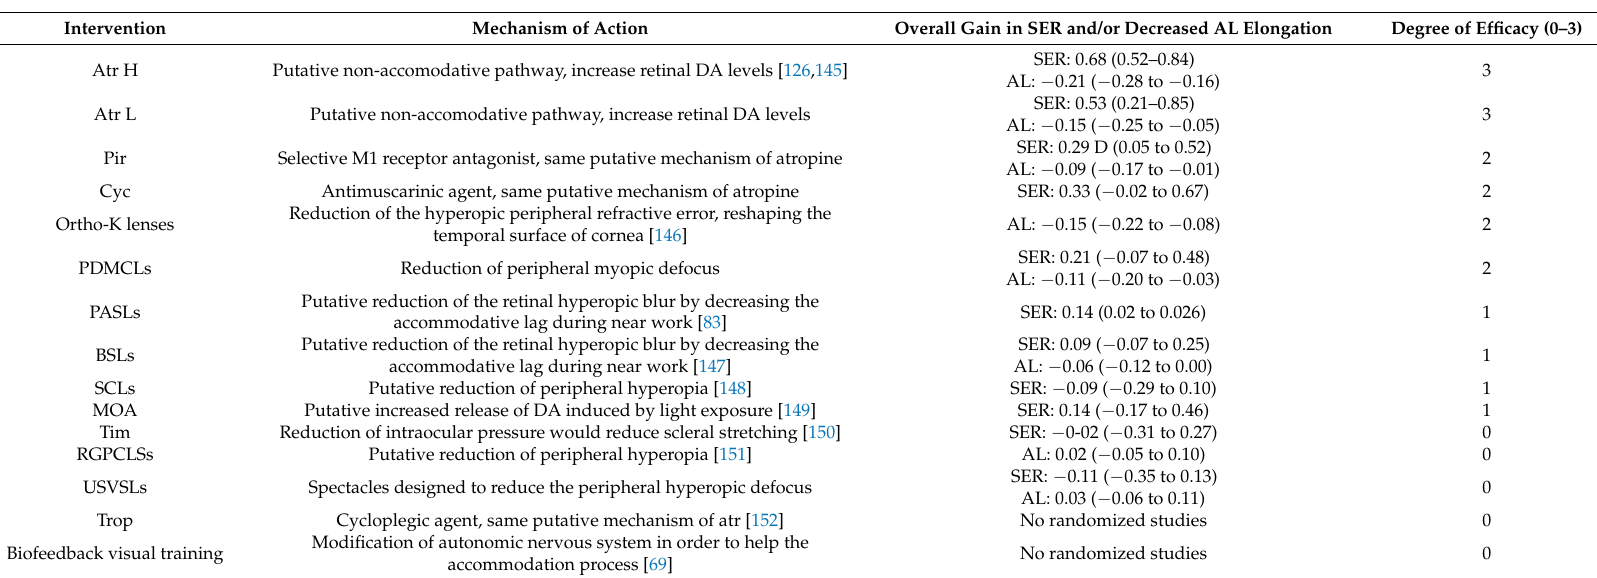
Cycloplegic agent, same putative mechanism of atr [152] Modification of autonomic nervous system in order to help the Biofeedback visual training accommodation process